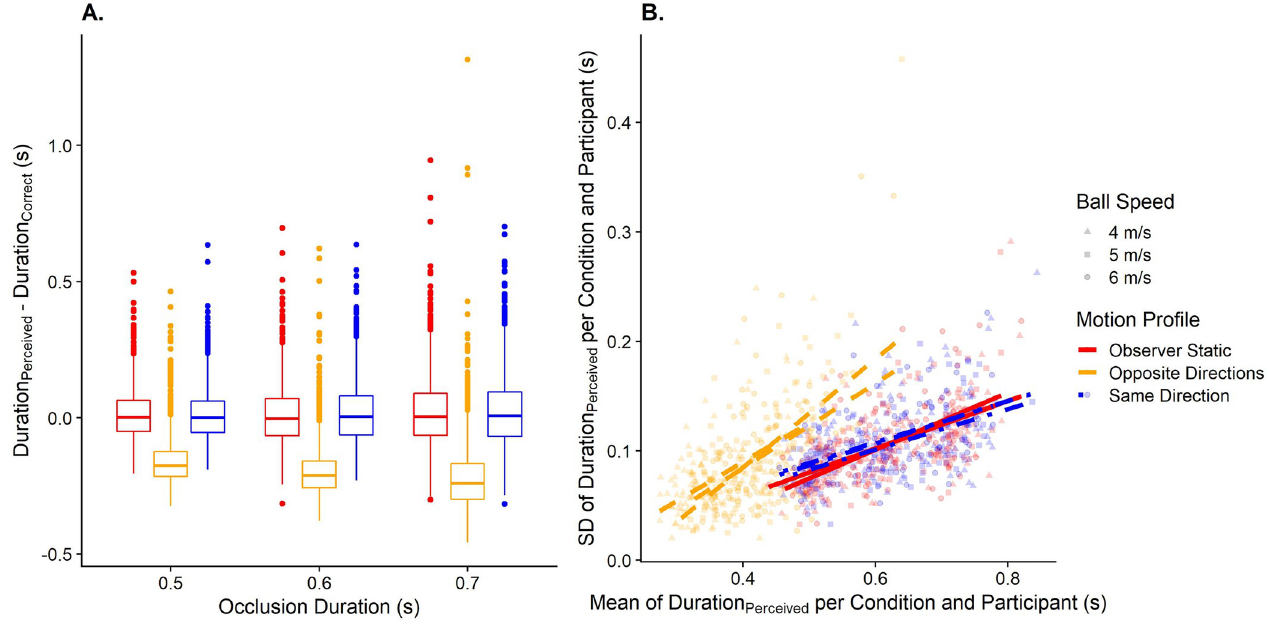
Fig 3. A. Predicted data for the timing error in the prediction task, divided up by occlusion durations (x axis) and motion profile (color-coded; left-most: “Observer Static”; in the middle: “Opposite Directions”; right-most “Same Directions”). B. Predicted data for variability in the prediction task. The y axis displays the standard deviation of the extrapolated duration per condition and participant, while the x axis corresponds to the mean of the extrapolated duration per condition and participant. The motion profile is coded with different colors and line types (red and continuous for “Observer Static”, yellow and dashed for “Opposite Directions” and blue and dashed-and-dotted for “Same Direction”). The lines are regression lines for their respective condition.